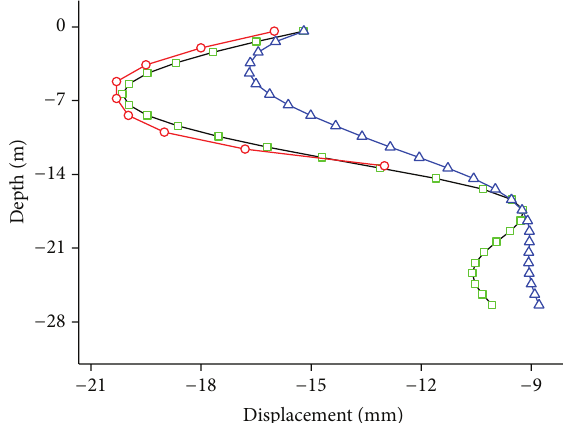
Figure 11: Displacement contrast of front-row pile and back-row pile.